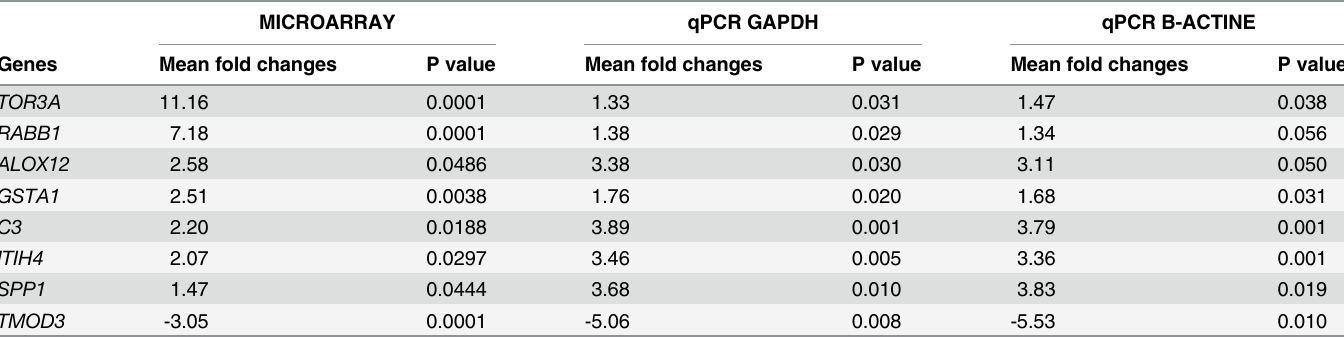
Table 4. RT-PCR confirmation of microarray.